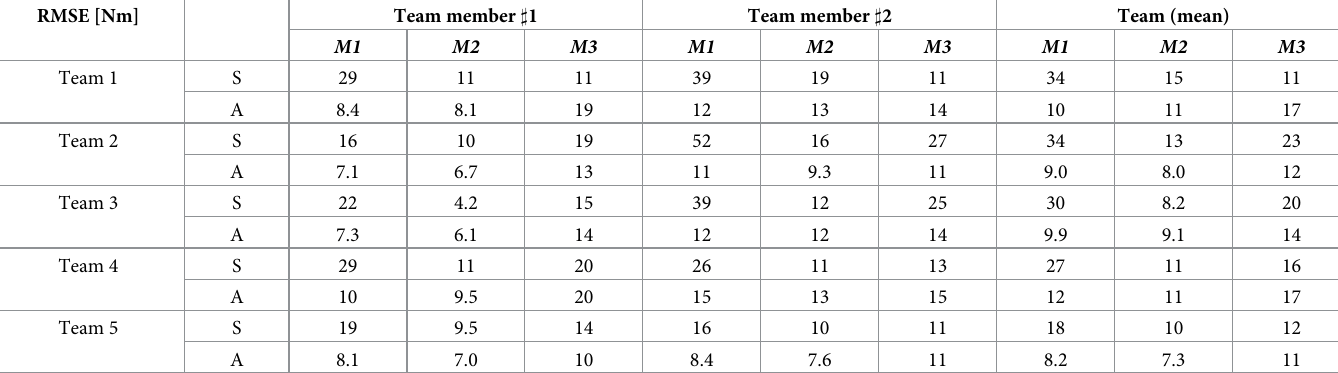
Table 4. RMSE for sagittal (S) and asymmetrical (A) L5/S1 joint moments for each team member and each prediction method. RMSE